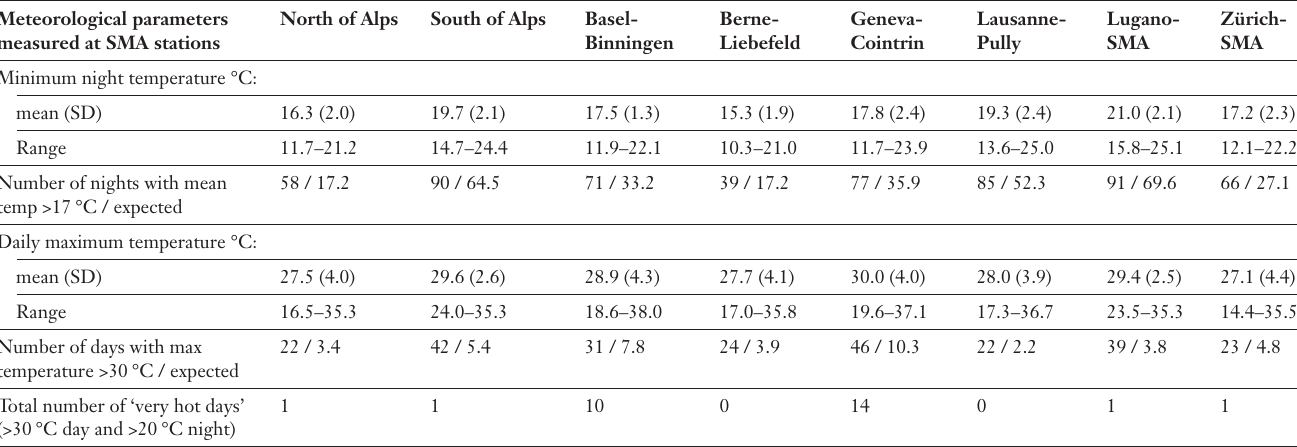
Plot of the daily per- centage difference between observed and predicted mortal- ity (bars) and of the deviation of daily apparent tempera- ture from the respec- tive 1990–2002–aver- age (line) for the region of Switzerland north of the Alps.